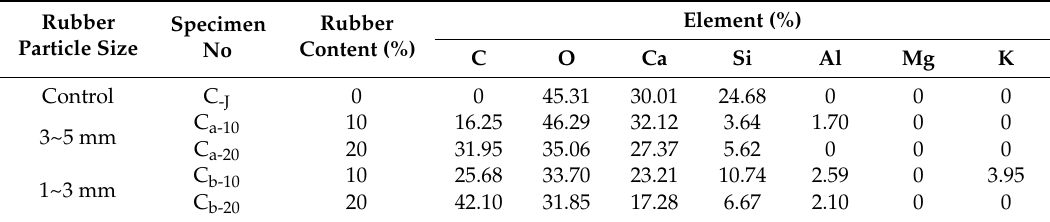
Figure 16. Energy distribution spectrograms of samples: ( a ) Rubber content 0% (control group), ( b ) rubber content 10% (rubber particle size 3~5 mm), ( c ) rubber content 20% (rubber particle size 3~5 mm), ( d ) rubber content 10% (rubber particle size 1~3 mm), and ( e ) rubber content 20% (rubber particle size 1~3 mm). Table 7. Content of major elements in the